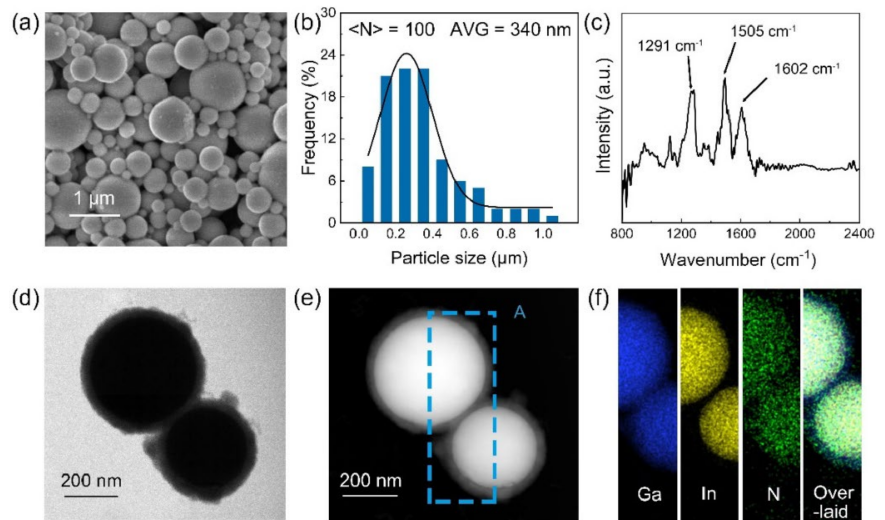
Figure 2. ( a ) SEM image and ( b ) lateral size distribution of the PDA-EGaIn nanocapsules. ( c ) IR spectra of the PDA-EGaIn nanocapsules. ( d ) TEM and ( e ) STEM images of the individual nanocapsule. ( f ) Ga (blue), In (yellow), N (green), and the overlaid elemental mapping of the nanocapsules detected from position A in ( e